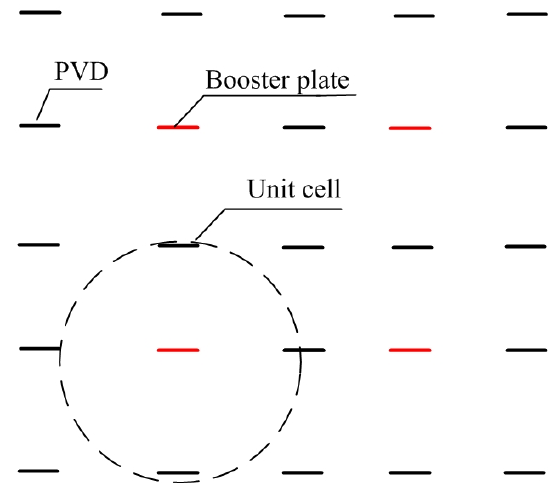
Figure 2. Booster plate: top view.